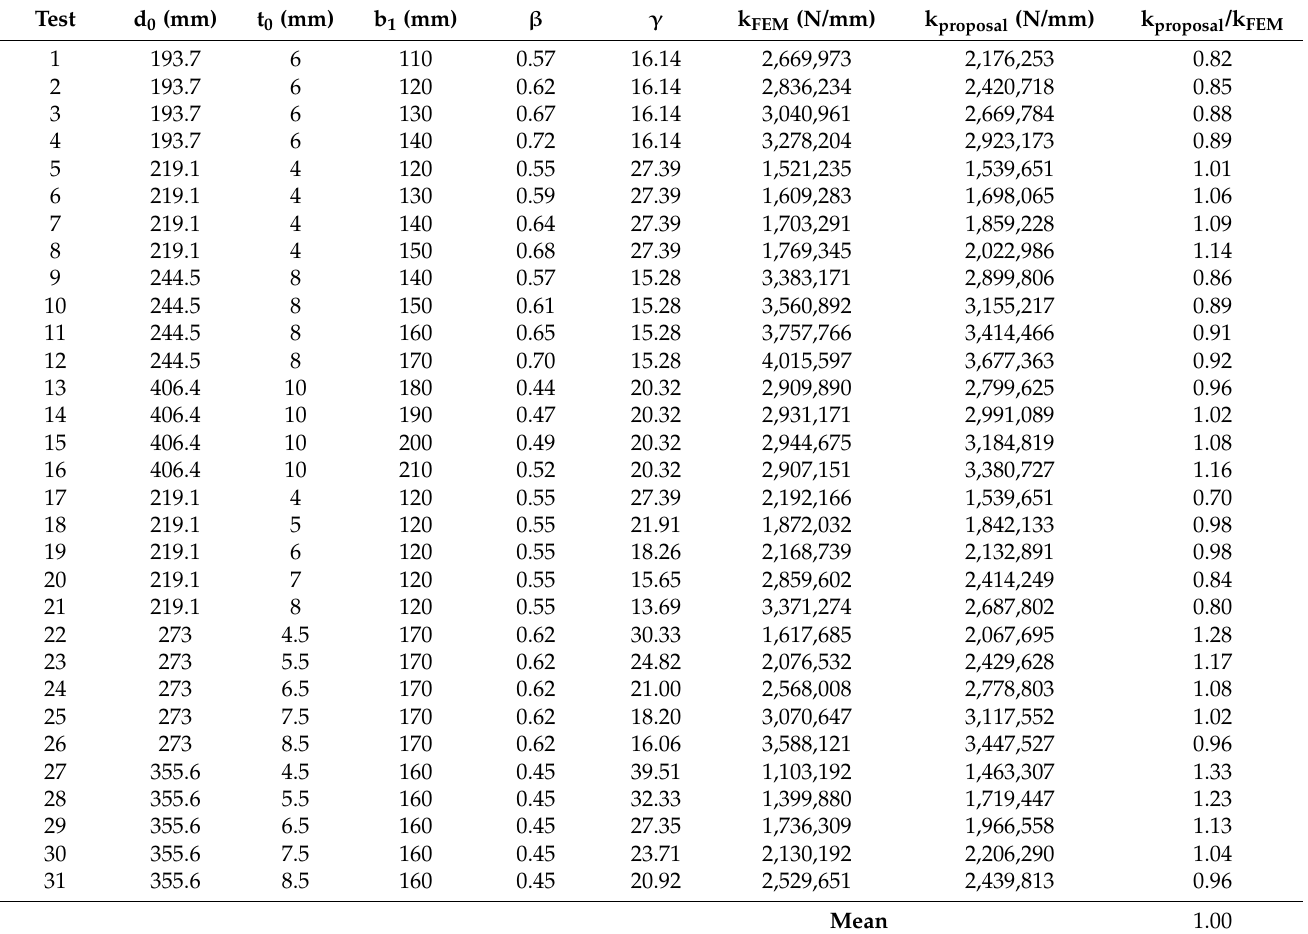
Table 5. Validation of the proposed formulation related to the